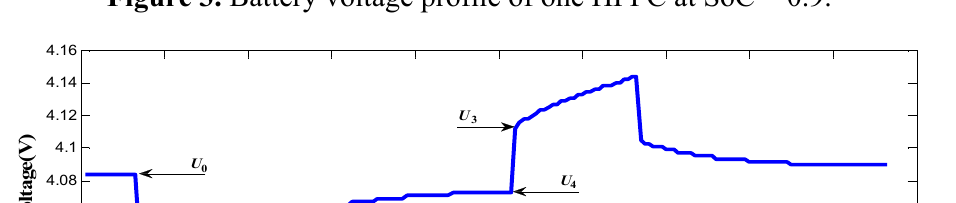
Figure 3. Battery voltage profile of one HPPC at SoC = 0.9.